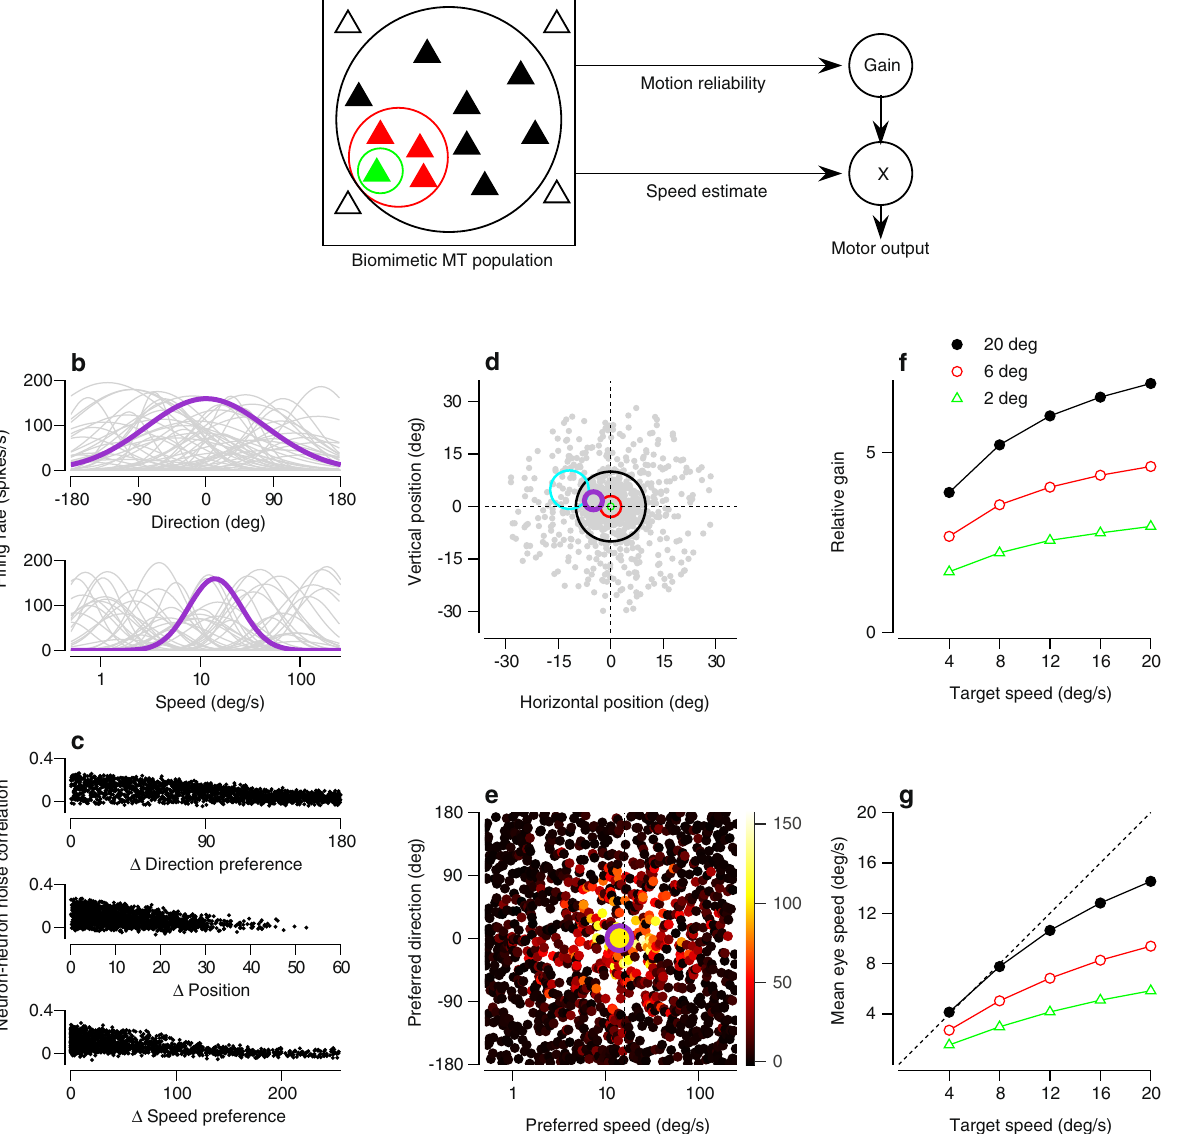
Fig. 4 A more biomimetic model of MT and the downstream pursuit circuit. a Overview of the biomimetic circuit model of pursuit. Activation of model middle temporal (MT) neurons (triangles within square, left) depends on patch size (colored circles). Each neuron drives (1) the motion reliability pathway, which computes a vector sum of MT activity (top) and (2) the speed estimation pathway, which computes a vector average (bottom). Application of the output of the motion reliability pathway to the output of the estimation pathway generates simulated pursuit (right). b Direction tuning (top) and speed tuning (bottom) of a random sample of model MT neurons. Purple highlights one neuron. c Noise correlations between model neurons as a function of the difference in direction preference ( Δ Direction preference; top), distance between receptive fi eld positions ( Δ Position; middle), and difference in speed preference ( Δ Speed preference; bottom). Each dot plots the measured noise correlation for a different pair of model neurons sampled from the population. d Receptive fi eld centers (gray points) of the population of MT neurons used to represent motion for pursuit. Green, red, and black circles correspond to the locations of the 2 deg, 6 deg, and 20 deg targets. Purple and cyan circles plot the classical receptive fi eld of two example neurons. e Response of each model neuron for an example trial (spikes/s; color). The center of each point corresponds to the neuron ’ s preferred direction and speed. Large purple symbol indicates the example neuron from panels b and d . f Mean gain of the population as a function of target speed and size. g Mean simulated eye speed as a function of target speed and size (colors as in panel f ). Source data are provided as a Source Data fi